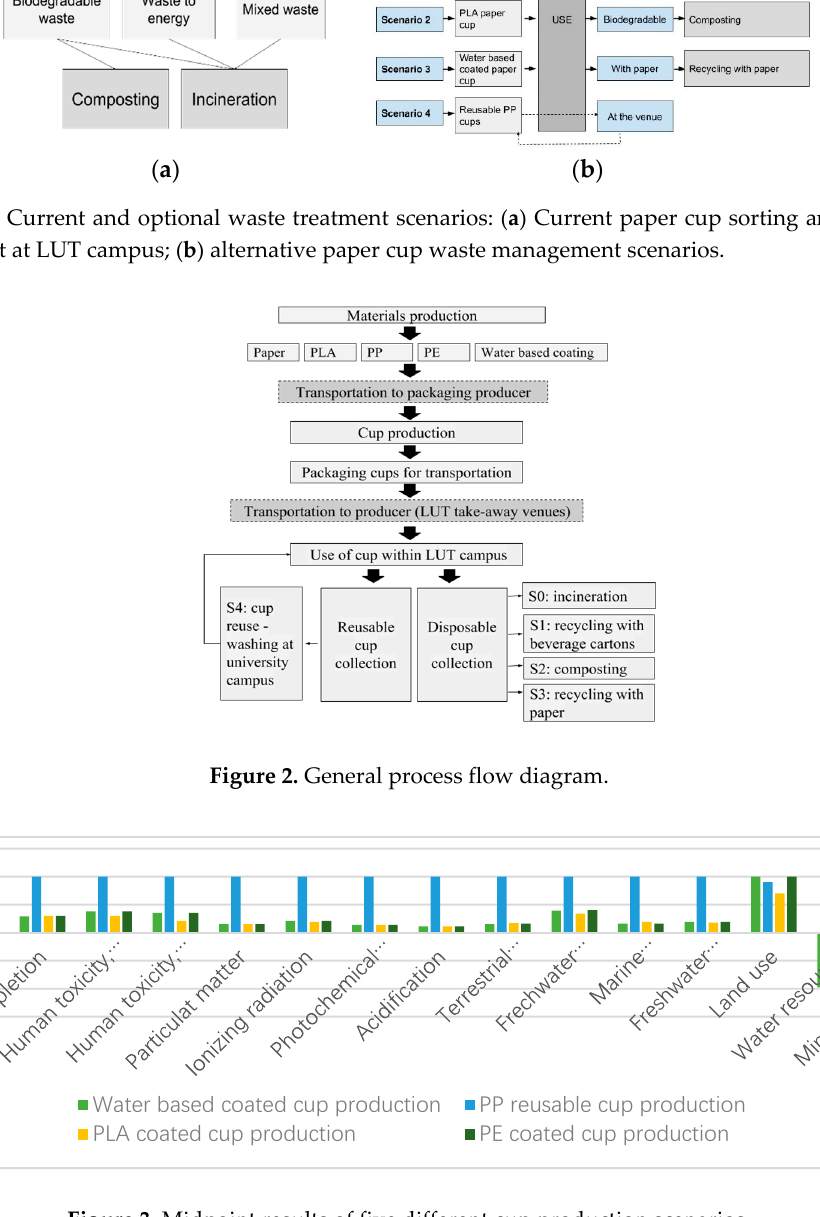
Figure 3. Midpoint results of five different cup production